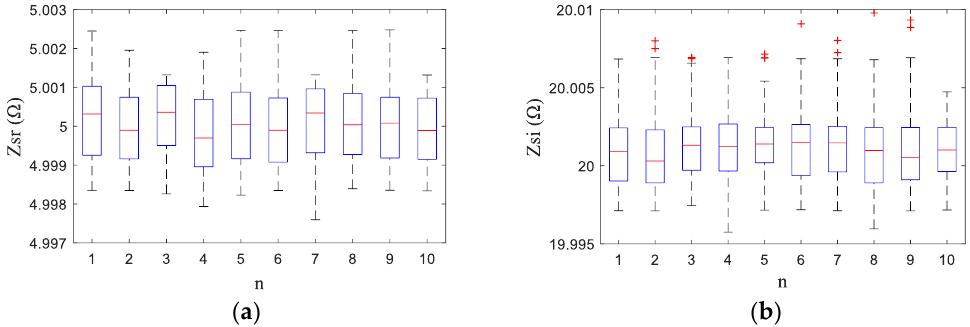
Figure 9. Results of method 1 in simulation II. ( a ) Result of real part; ( b ) Result of imaginary part.